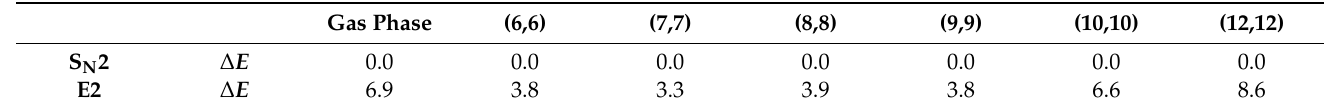
Table 3. Reaction energies (kcal mol − 1 ) of the S N 2, and syn - and anti -E2 reaction mechanisms inside CNT cavities.